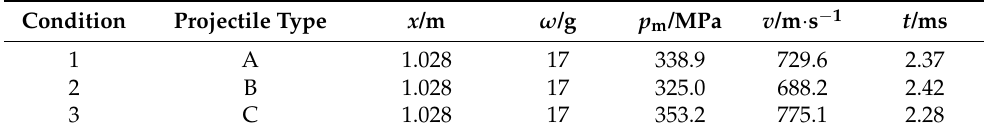
Table 4. Interior ballistics results with three jet